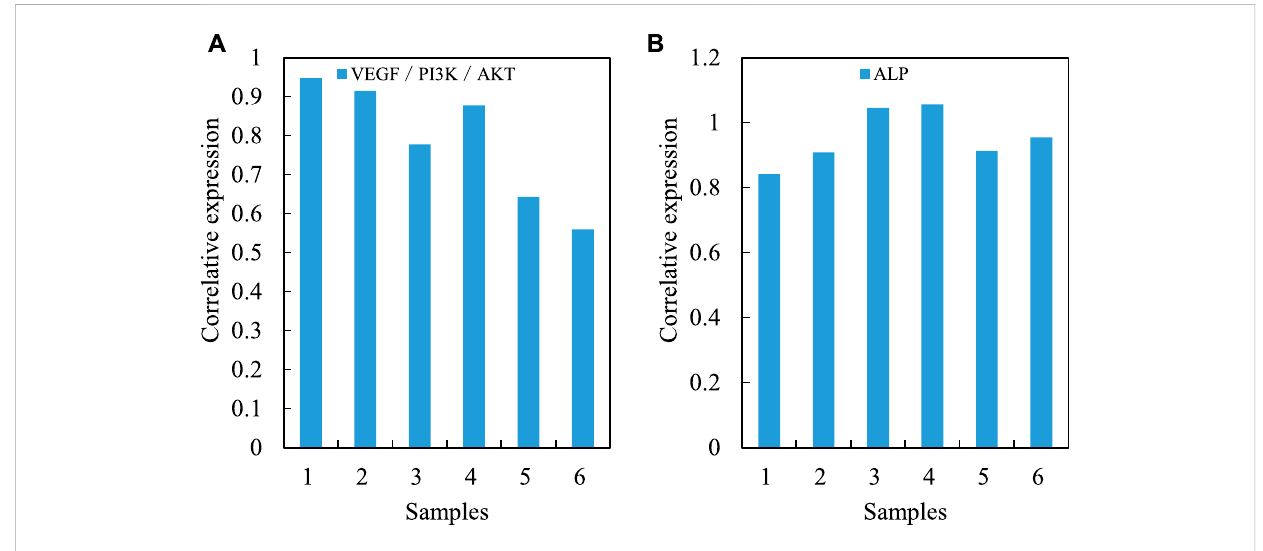
FIGURE 9 Comparison of regulatory effects of MicroRNA-206. (A) VEGF/PI3K/AKT signal expression (B) MicroRNA-206 inhibitor transfection of ALP gene in